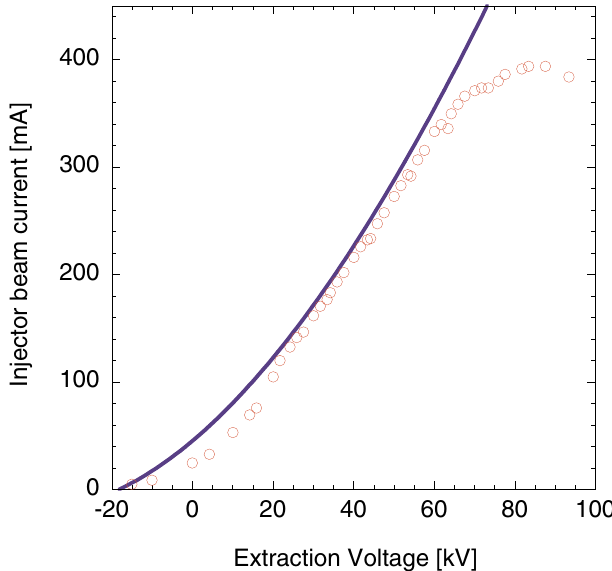
FIG. 15. (Color) Measured (circles) and predicted (curve) beam current downstream of injector as a function of extraction voltage for a fixed Marx voltage ( V